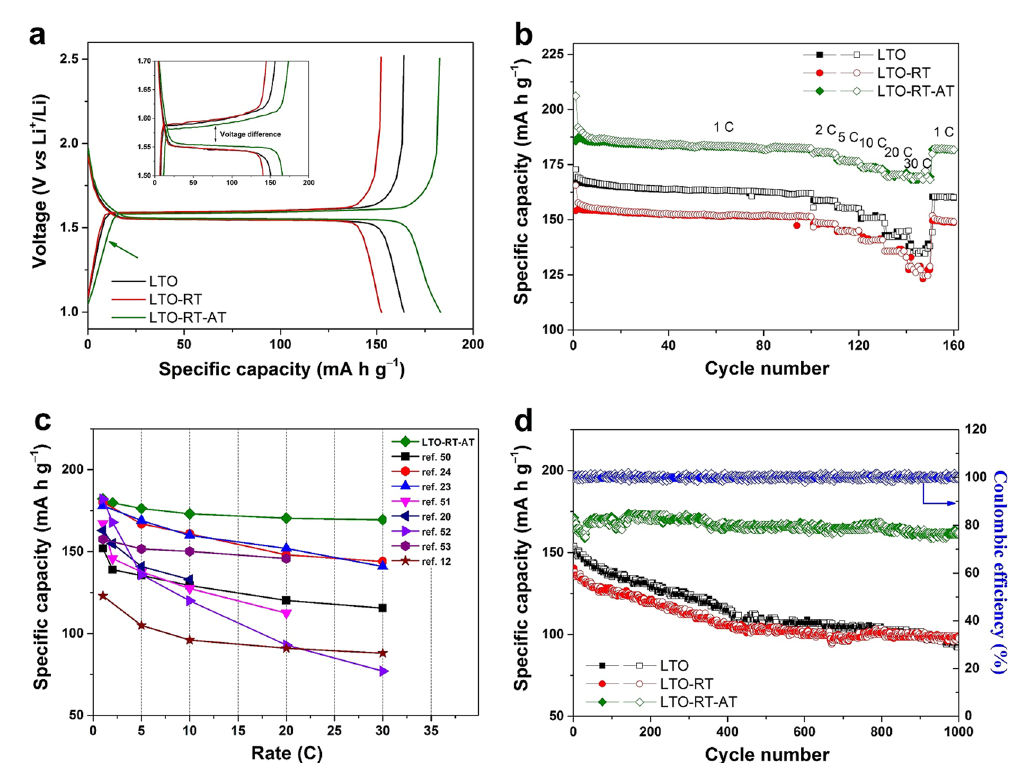
Figure 6. ( a ) Galvanostatic charge/discharge curves of pure LTO, LTO-RT and LTO-RT-AT, ( b ) cycle and rate performance at various rates of 1 to 30 C, ( c ) comparison of the rate capability of the LTO-RT-AT with other recently reported LTO-TiO 2 composites, ( d ) long-term cycle performance and corresponding coulombic efficiency of